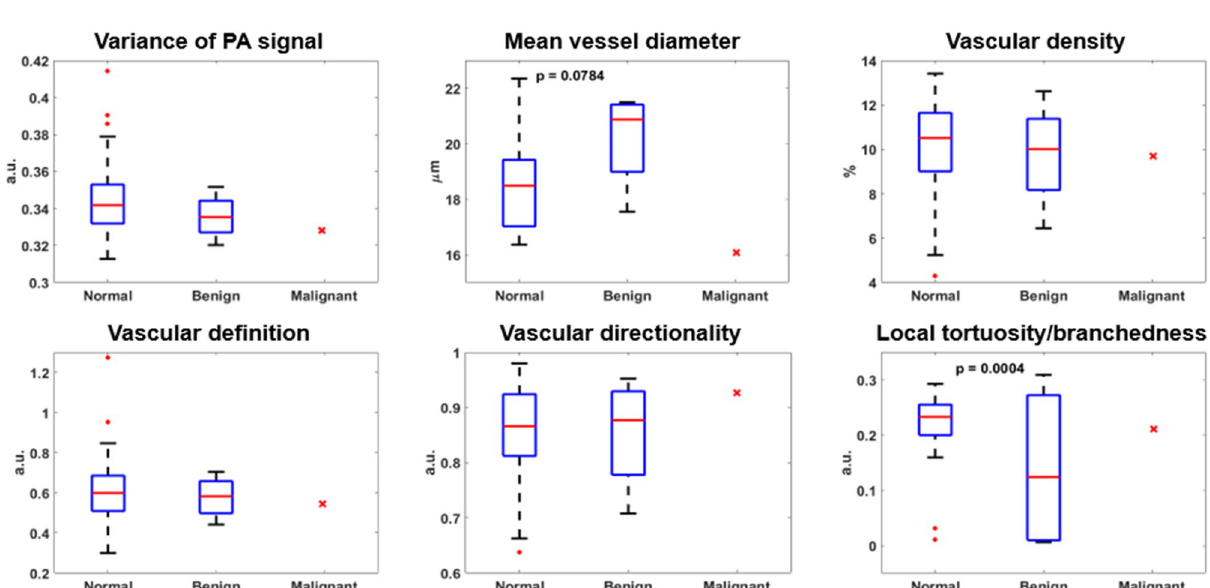
Figure 8. Comparison of morphological vascular features between normal (n = 33) and benign (n = 4) fallopian tubes. A red x marks the results from the single case of malignant tubal lesion, not included in the calculation of p